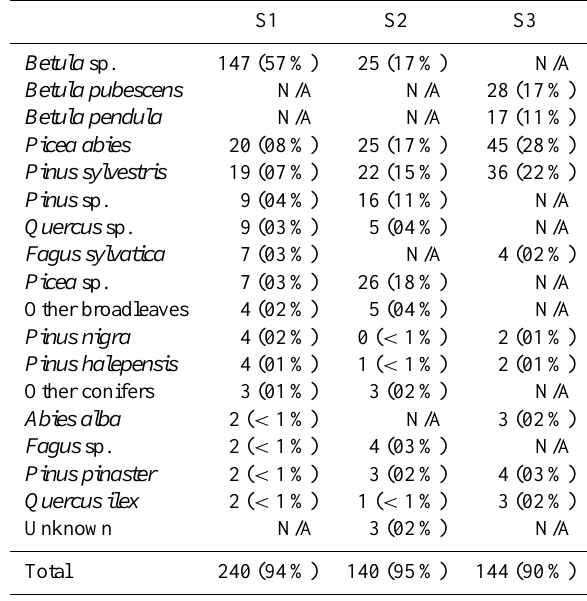
Table 4. Top emitters of sesquiterpenes (based on annual data, orig- inal countries), selected so that at least the ten most important emit- ters for each inventory is shown. Values in Gg yr − 1 .